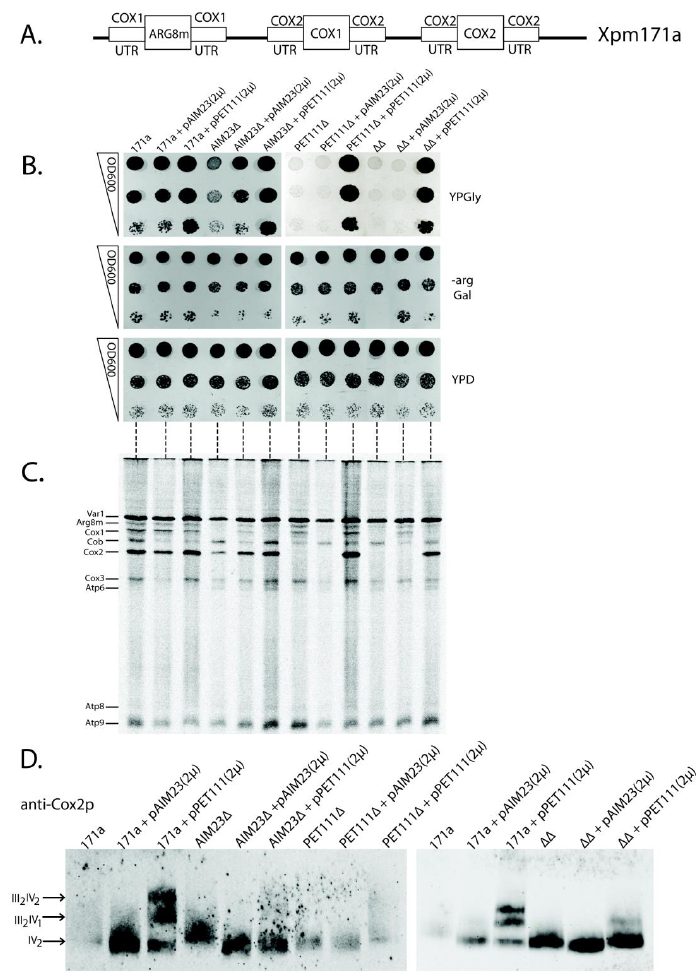
Figure 3. Increased Pet111p amounts ensure proper translation of COX2 mRNA in the absence of Aim23p. ( A ) Scheme of the mitochondrial genome organization of XPM171a strain. ( B ) The pictures of 3-days yeast growth on the plates with different media (indicated on the right: YPD—full glucose-containing medium, -arg Gal—synthetic arginine-lacking medium with galactose, YPGly—full glycerol-containing medium). Strains are depicted on the top. 171a—XPM171a (parental strain for all other strains). AIM23∆— AIM23 gene disrupted, PET111∆— PET111 gene disrupted, ∆∆—both genes disrupted. pAIM23(2µ)—strain transformed with the two-micron plasmid bearing AIM23 gene, PET111(2µ)—strain transformed with the two-micron plasmid bearing PET111 gene. The ten-fold consecutive dilutions of the yeast suspensions were plated. The experiment was done in three biological replicates; the characteristic picture is presented. ( C ) Mitochondrial translation products in the yeast strains described in the legend to Figure 3B. Fractions of 35 S-containing proteins (50 µ g of total protein per lane) were PAGE-separated. Mitochondrially-encoded proteins were then visualized by radioautography. The order of mitochondrial proteins loading on the gel is the same as the order of plating the corresponding yeast strains on Figure 3B which is marked by horizontal dashed lines between two panels. Individual mitochondrial proteins are depicted on the left according to the original article where XPM171a strain has been created [31]. The experiment was done in three biological replicates; the characteristic picture is presented. ( D ) Analysis of the respiratory chain supercomplexes formation in the same yeast strains. Visualization was done by Western blot hybridization with antibodies against Cox2p after complexes separation by Blue Native PAGE. Designations of the strains are the same as in Figure 3B; they are indicated on the top. Supercomplexes with di ff erent stoichiometric ratios of complexes III and IV are indicated by arrows on the left. The experiment was done in three biological replicates; the characteristic picture is